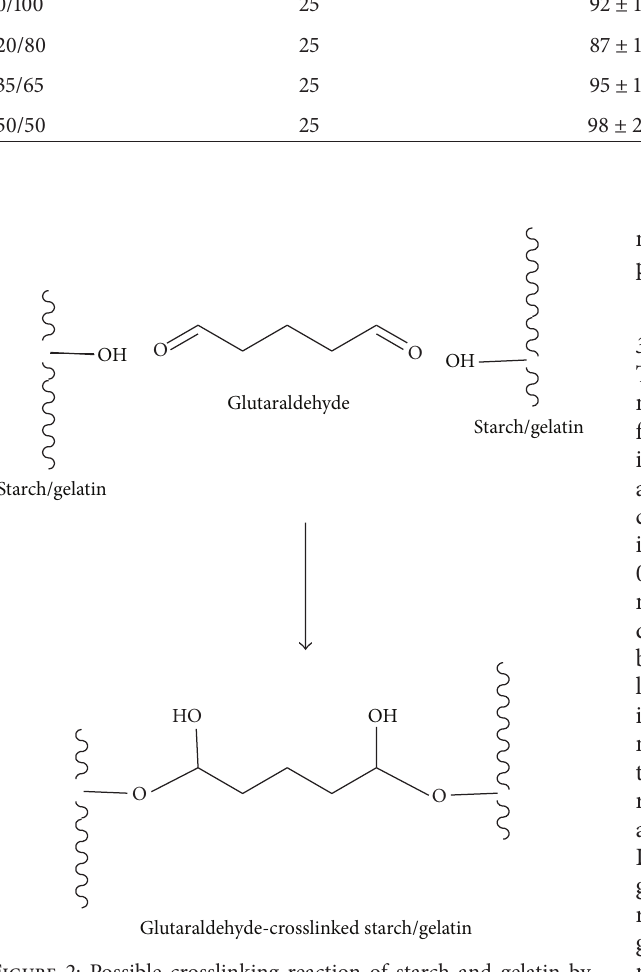
Figure 2: Possible crosslinking reaction of starch and gelatin by